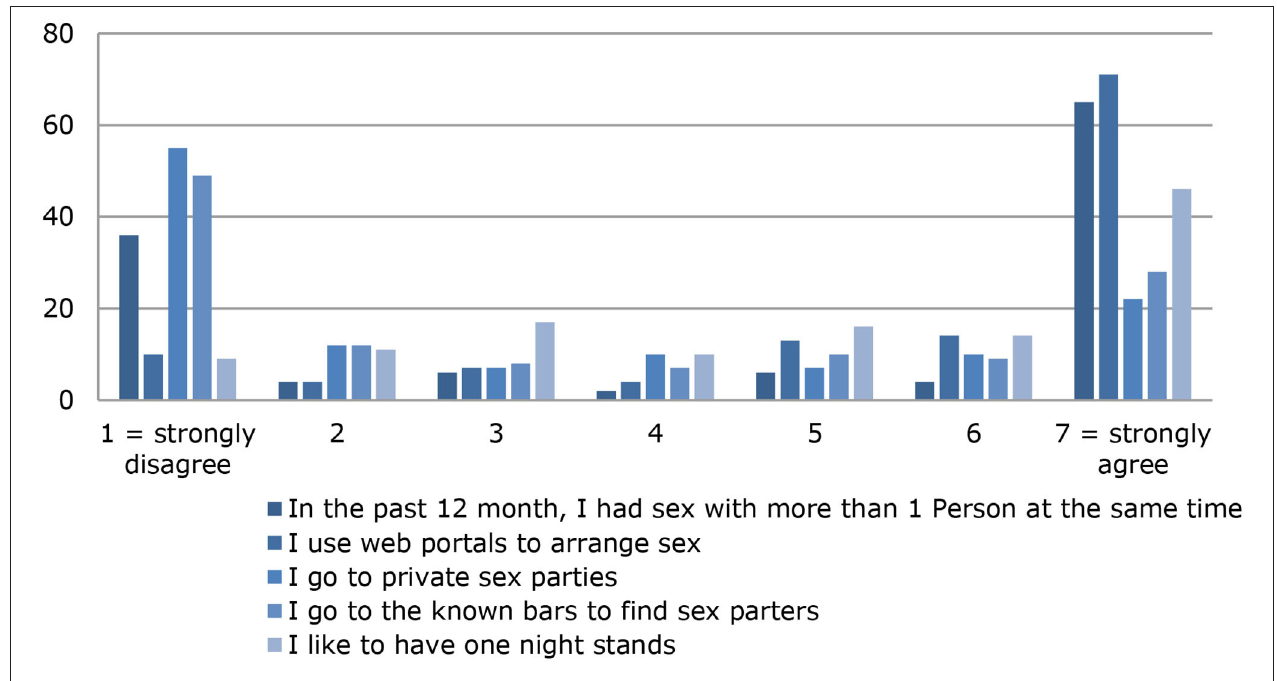
FIGURE 3 | Sexual